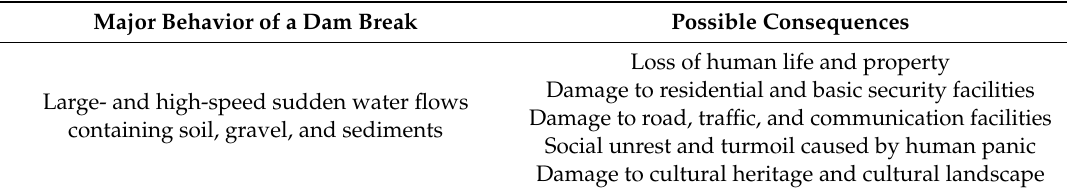
Table 1. Major behavior of a dam break and possible social impact [57].